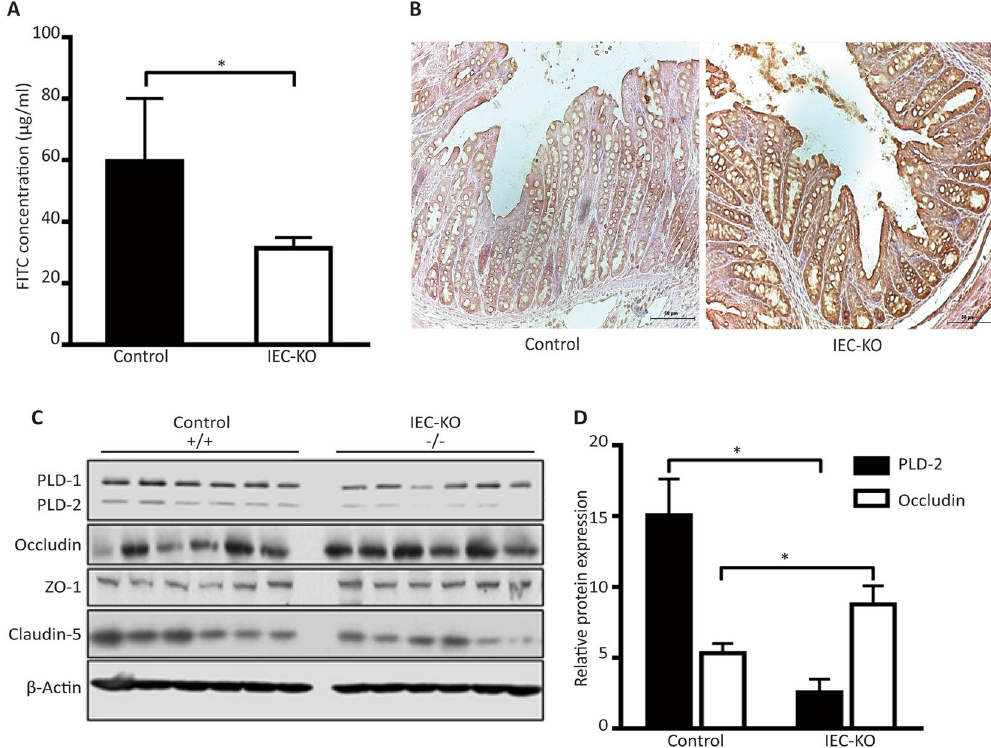
Figure 3. Intestine-specific knockdown of PLD2 decreases occludin expression in mice. ( A ) In-vivo permeability assay in control and IEC KO mice, conducted after 4 hours of treatment with FITC-dextran, administered by oral gavage. FITC concentration in the serum was measured using a spectrofluorometer and is shown as the mean ± SEM. ( B ) Immunohistochemistry assessing the expression of occludin in the paraformaldehyde-fixed paraffin-embedded sections of colon tissue from control and IEC KO mice. Scale bar is 50 µ m. ( C ) Western blots of occludin in isolated colon epithelial cells from the control and IEC KO mice. ( D ) Associated western blot quantification. All data are shown as the mean ± SEM. * p <